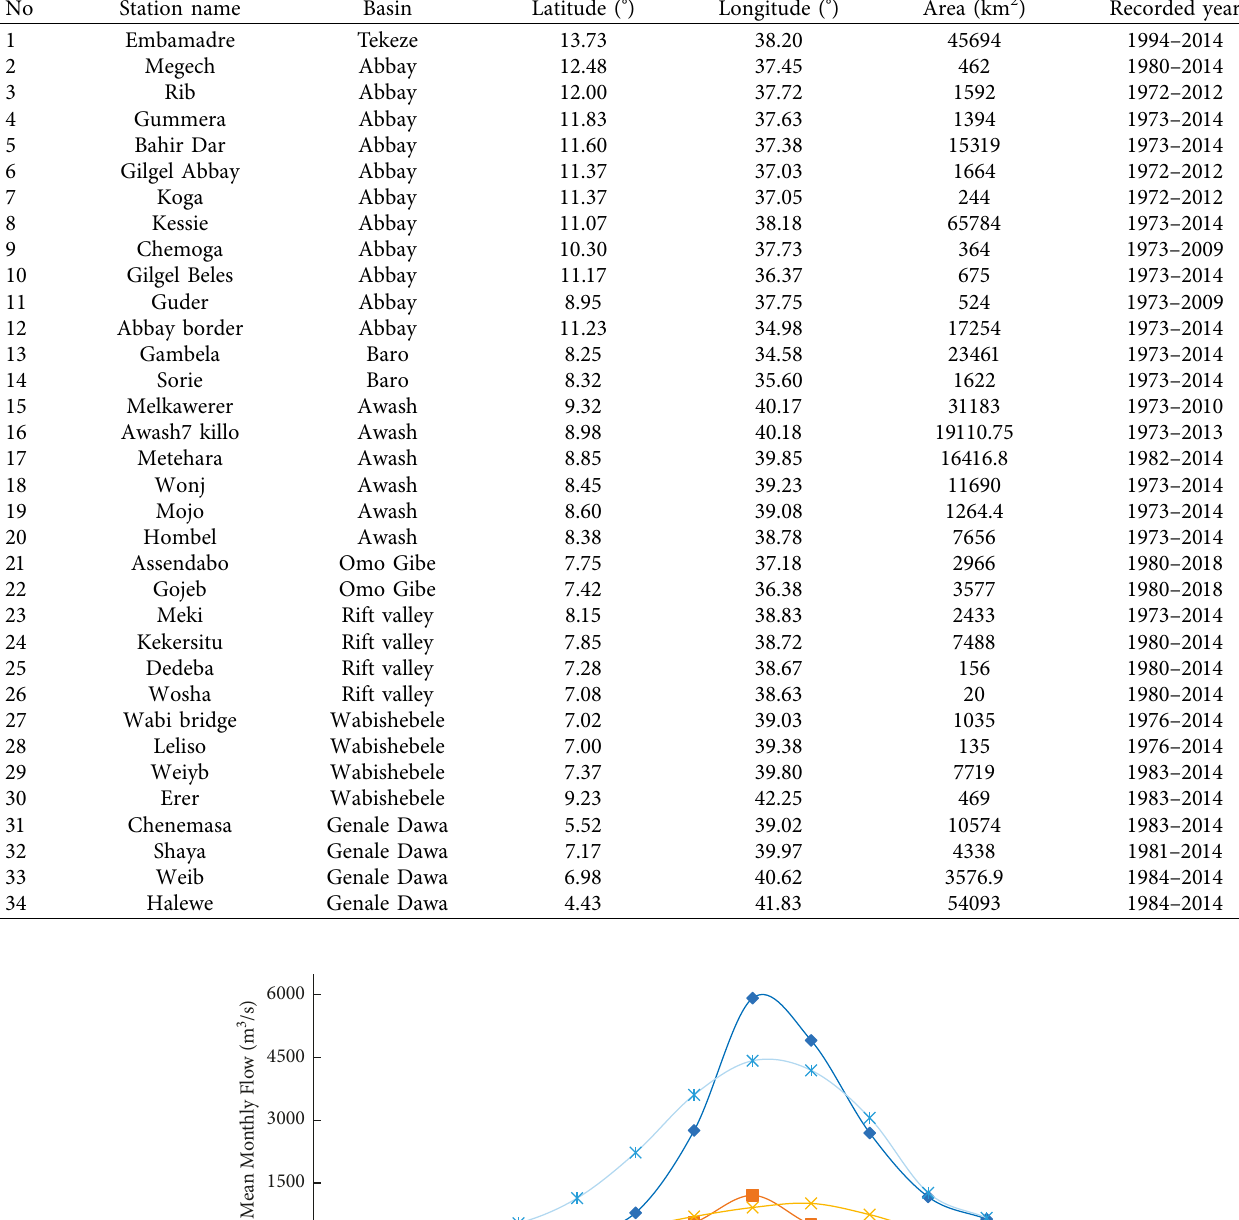
Table 1: Streamflow stations location and a corresponding record year in each river basin.